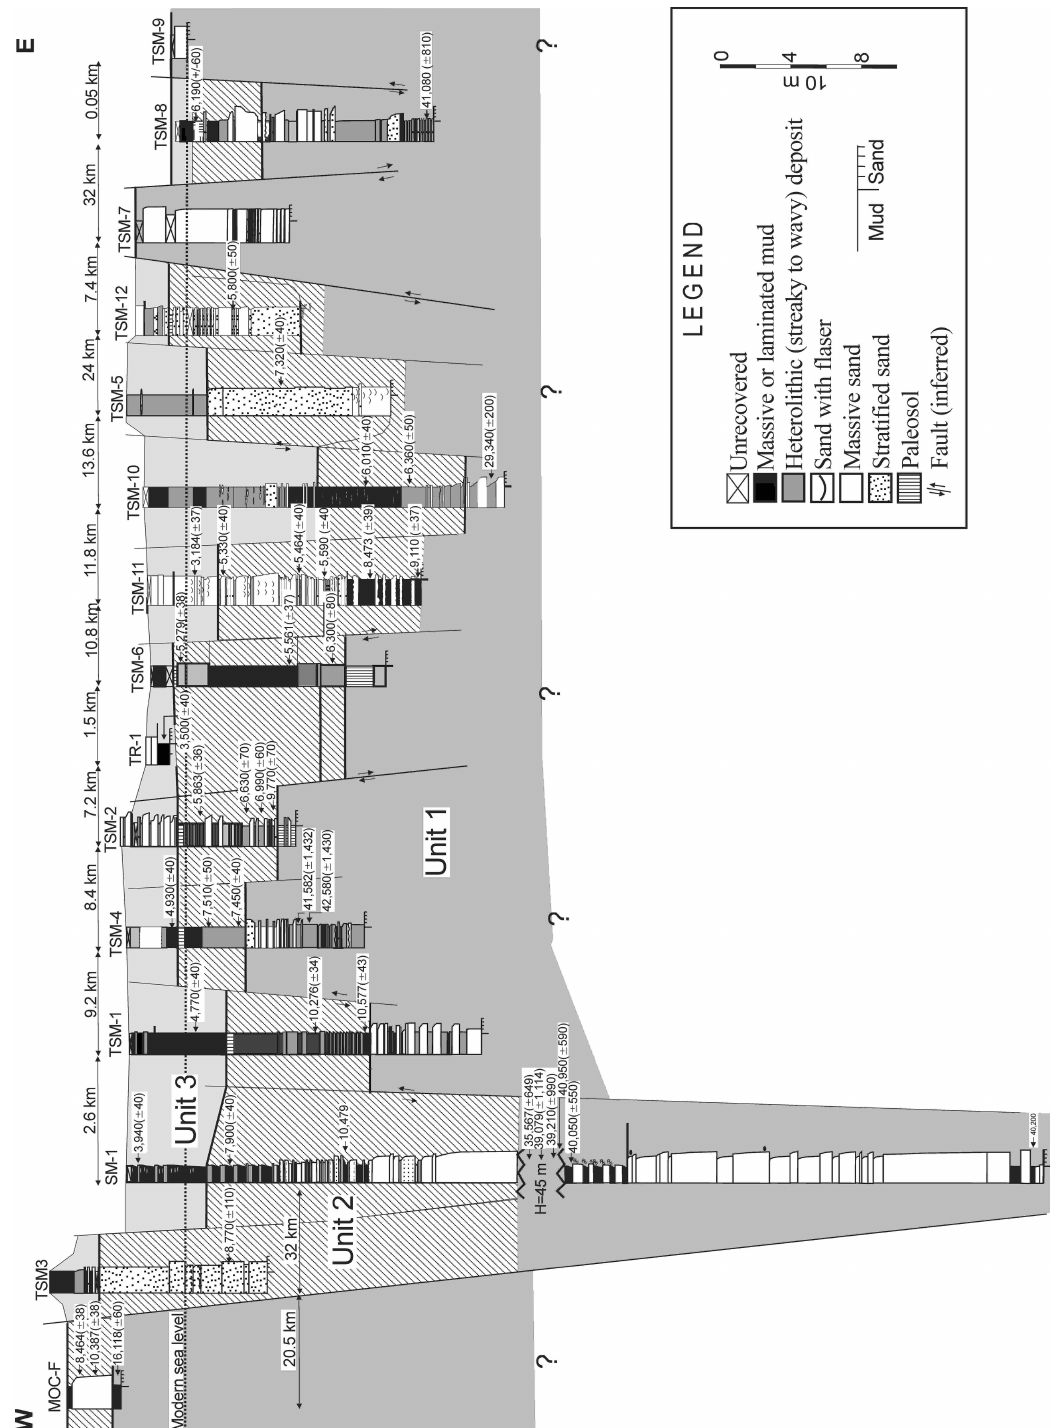
Fig. 3 – Lithostratigraphic profiles used in this study, with the interpreted stratigraphic framework established for the latest Quaternary sedimen- tation. Faults among drills were included in this section for illustrative purposes, as they might actually correspond to a fault zone. See text for further discussion concerning to the presence of these faults in the study